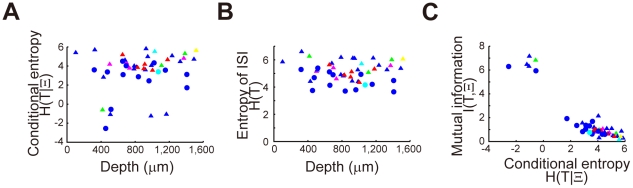
Information measures for cortical neurons.(A, B) The conditional response entropy and entropy of ISI distribuions, respectively, for pyramidal (triangles) and fast-spiking (circles) neurons recorded at various depths of the cortex. Colors indicate the motor component represented by each neuron (see the legend of
Figure 2D
). (C) Correlations between the conditional response entropy and mutual information for the individual neurons.